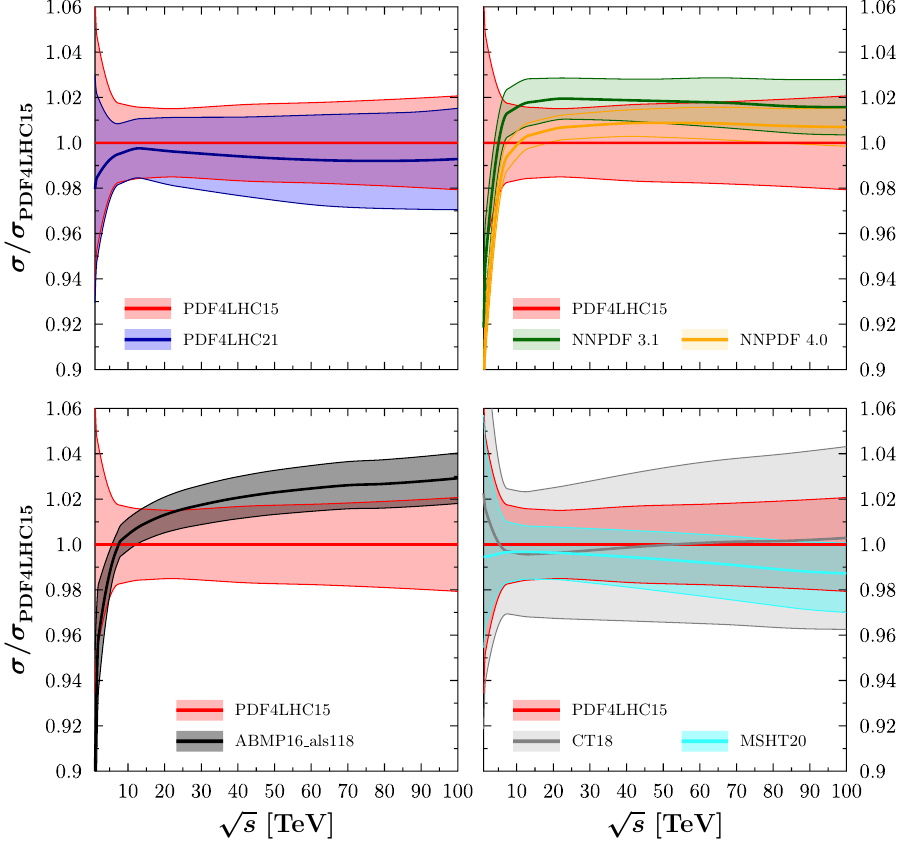
Figure 10 . Dependence on the choice of the PDF set of the Born-improved HTL gluon fusion Higgs production cross section at N 3 LO in QCD as a function of the proton-proton c.m. energy The results are normalized to the central PDF4LHC15 PDF set and the 68% CL PDF uncertainties are represented by bands for all sets and calculated according to the prescription of ref. [67]. The comparison is between PDF4LHC15 and: PDF4LHC21 (upper left panel); NNPDF 3.1 and NNPDF 4.0 (upper right panel); ABMP16_als118 (lower left panel); CT18 and MSHT 20 (lower right